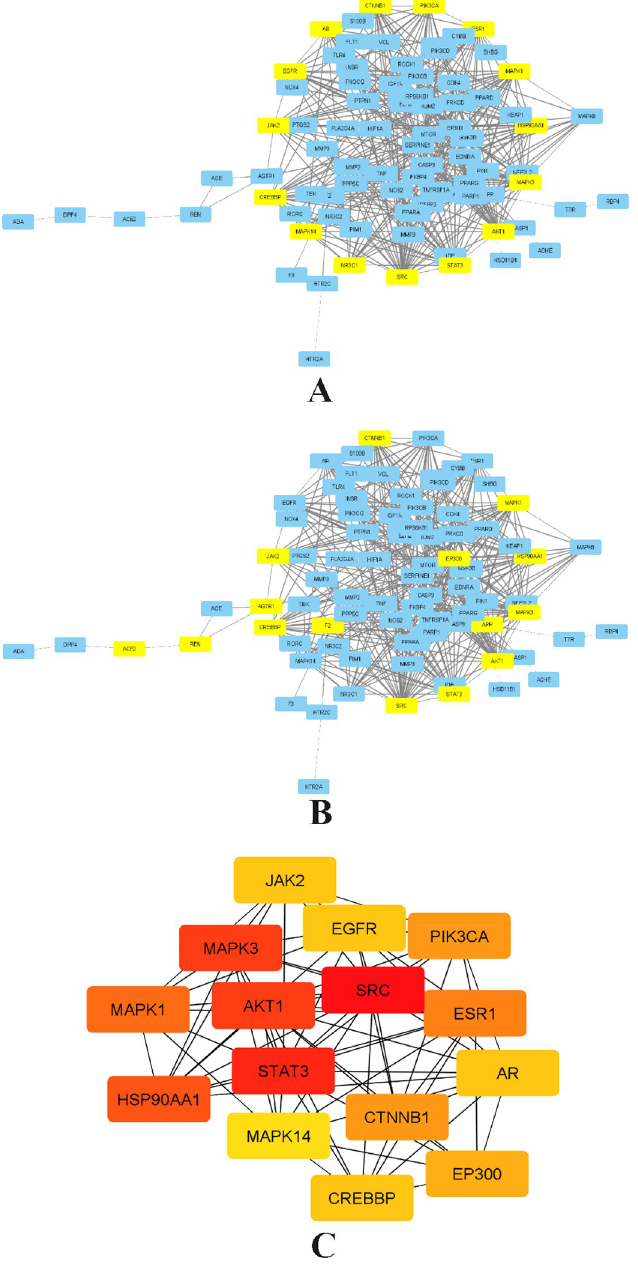
Fig 6. The topological screening for identifying subnetwork network. The PPI network diagram of 15 core targets was obtained by screening 113 targets. A) First filtration of network by CytoNca, the yellow nodes were screened with each score higher than median. B) second subnetwork filtration via CytoNca. The yellow nodes were screened with a score higher than the median. C) core key subnetwork of top 15 nodes analyzed by CytoHubba. pocket, occupying the cleft present in the inhibitor binding site (Fig 7) . The compound caffeic acid was predicted to form a total of 7 intermolecular interactions, with 3 of them being hydro- gen bonds. With these interactions, the binding affinity of caffeic acid was found to be -8.0 kcal/mol. Compound DBDEA had 11 intermolecular bonds and 3 hydrogen bonds with a